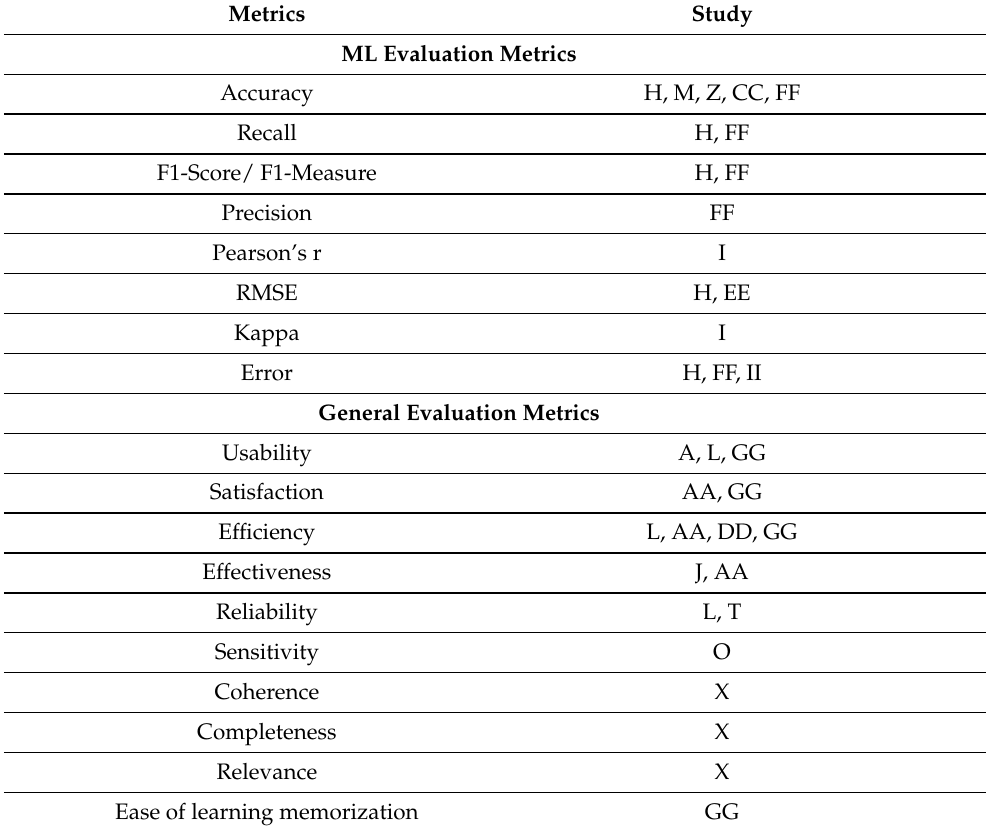
Table 10. Evaluation metrics used in the selected